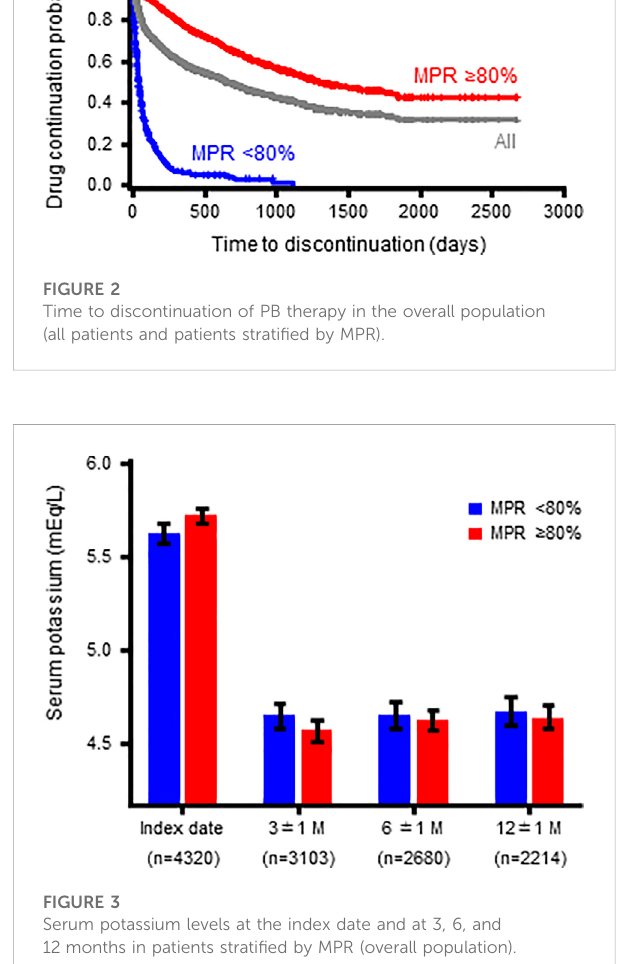
There were signi fi cant differences in the S-K levels at the index date and at 3 months, but not at 6 and 12 months, between the two groups. A similar trend was observed for the focused subpopulation (Supplementary Figure S3; Supplementary Table S5).